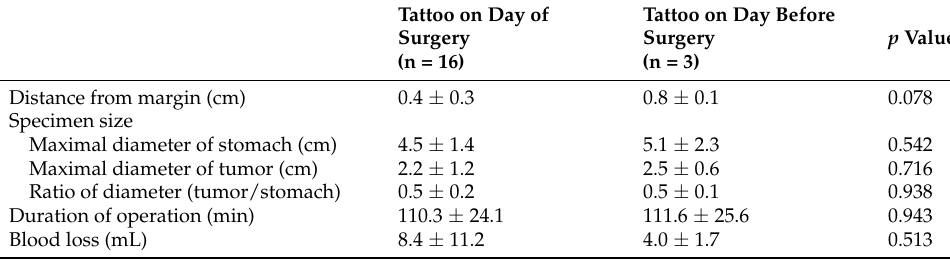
Table 4. Surgical